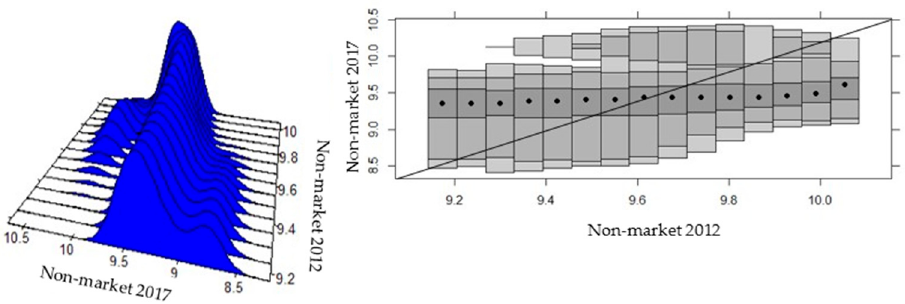
Figure 14. Intra-distribution dynamics of provincial productivity in the non-market service subsector, 2012–2017. Source: Own elaboration based on the Regional Accounts of the BCE [46]; ENEMDU surveys from the INEC [47] (several years) and stacked conditional density plot (SCD) in R.